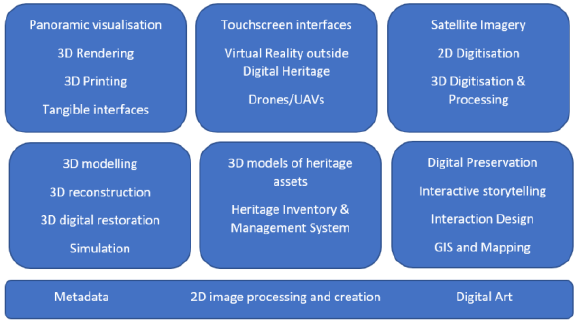
Figure 21. Graphic of components: Virtual Museum Projects. Deliverable Report. D 8.9 European Virtual Museum